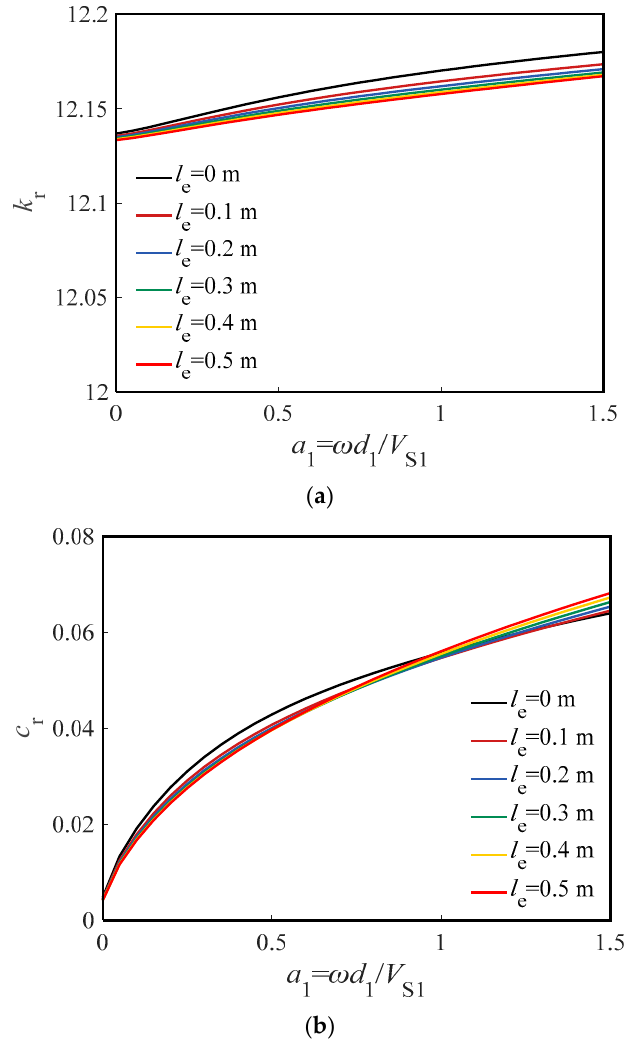
Figure 8. Influence of weak pile segment length on the RDI of pile head. ( a ) Stiffness factor of RDI and ( b ) damping factor of RDI.